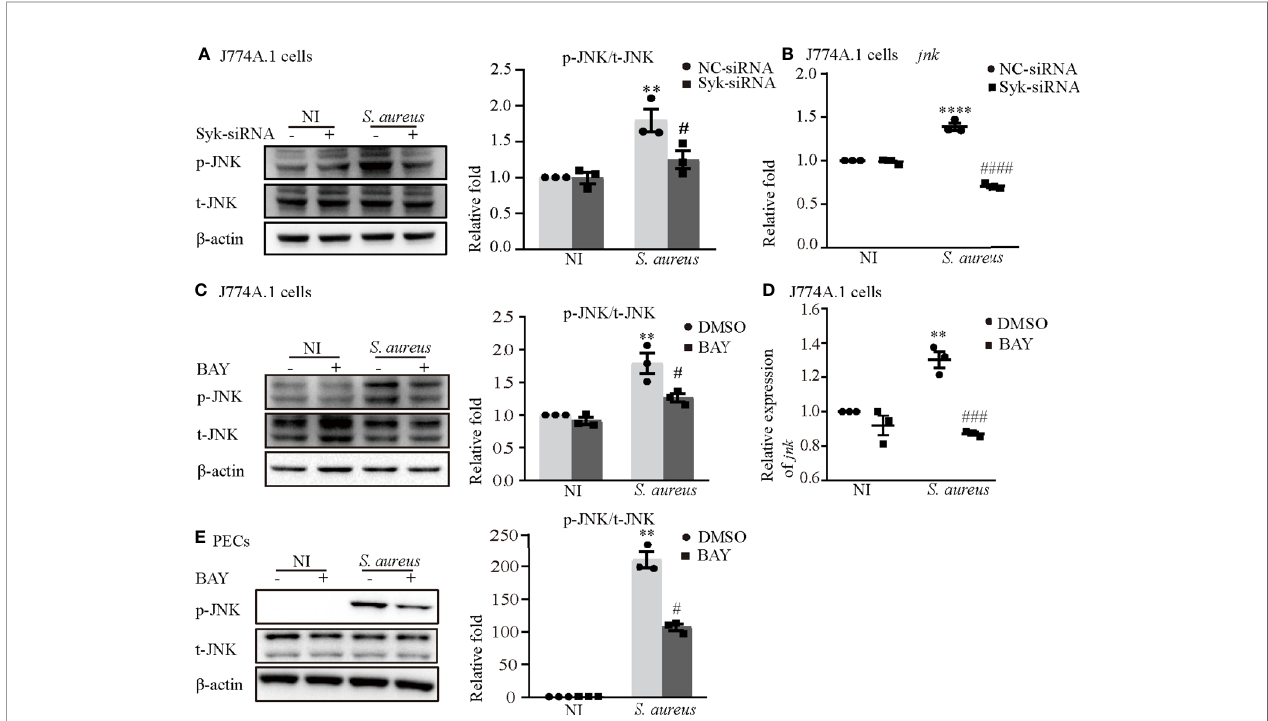
FIGURE 7 | Syk/JNK signaling was critical for activation of the NLRP3 in fl ammasome upon S. aureus infection. Macrophages were infected with S. aureus (MOI of 5) for 2 h by pretreated with or without Syk-siRNA (A , B) for 48 h or Syk inhibitor (BAY) (C – E) for 2h. (A) The protein expression level of p-JNK was detected by western blot and analyzed by relative densitometric quanti fi cation in J774A.1 cells. (B) The mRNA expression level of jnk was quanti fi ed by RT-PCR. (C) The protein expression level of p-JNK was detected by western blot and analyzed by relative densitometric quanti fi cation in J774A.1 cells and PECs (E) . (D) The mRNA expression level of jnk was quanti fi ed by RT-PCR. Similar results were obtained in three independent experiments in data. Data shown are means ± SEMs; ** P < 0.01, **** P < 0.0001 vs . non-infection control group, # P < 0.05, ### P < 0.001, #### P < 0.0001 vs. infection control